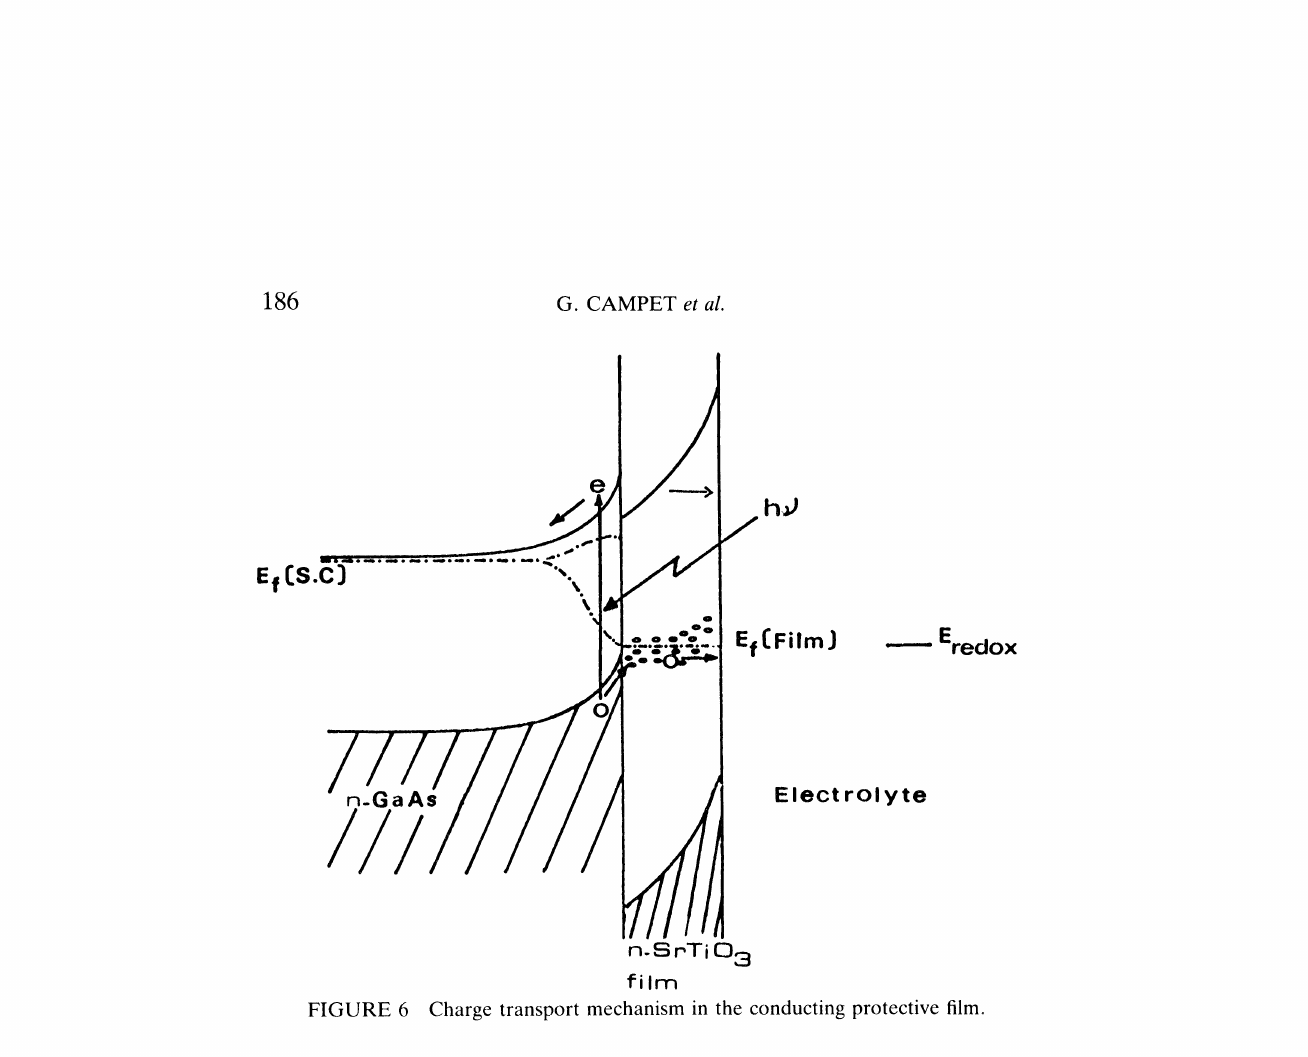
FIGURE 6 Charge transport mechanism in the conducting protective